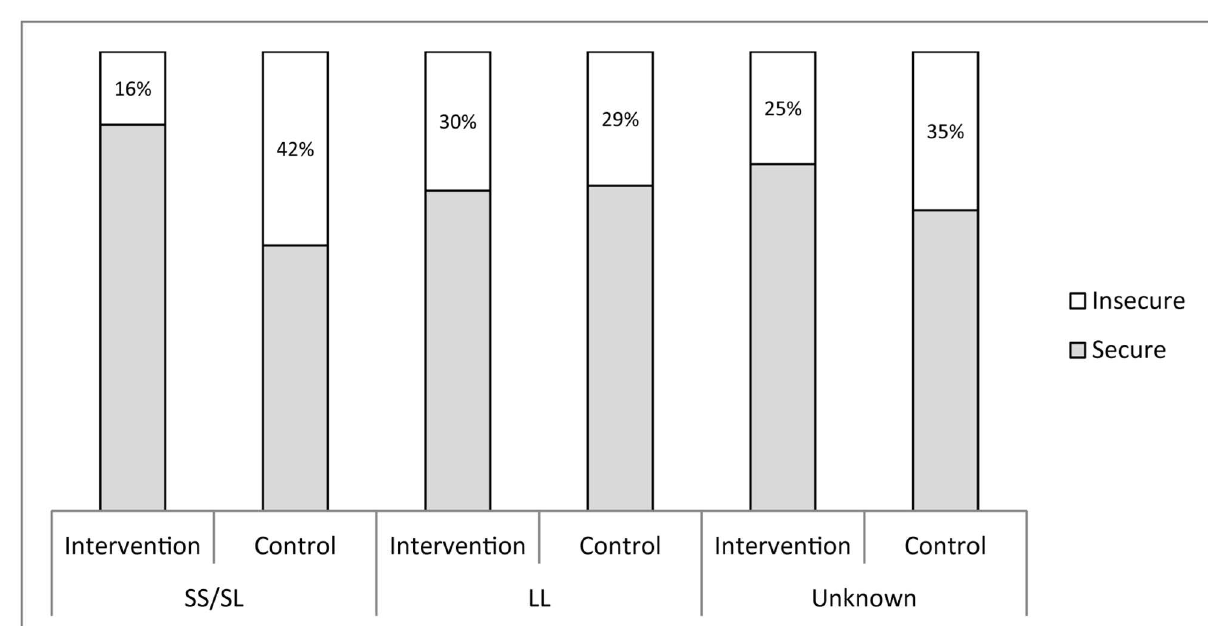
Fig 3. Efficacy of the home-visiting intervention when 5HTTLPR genotype is and is not taken into account. 5HTTLPR, 5HTT- linked polymorphicregion; LL, long/long;SS/SL, short/short or short/long.